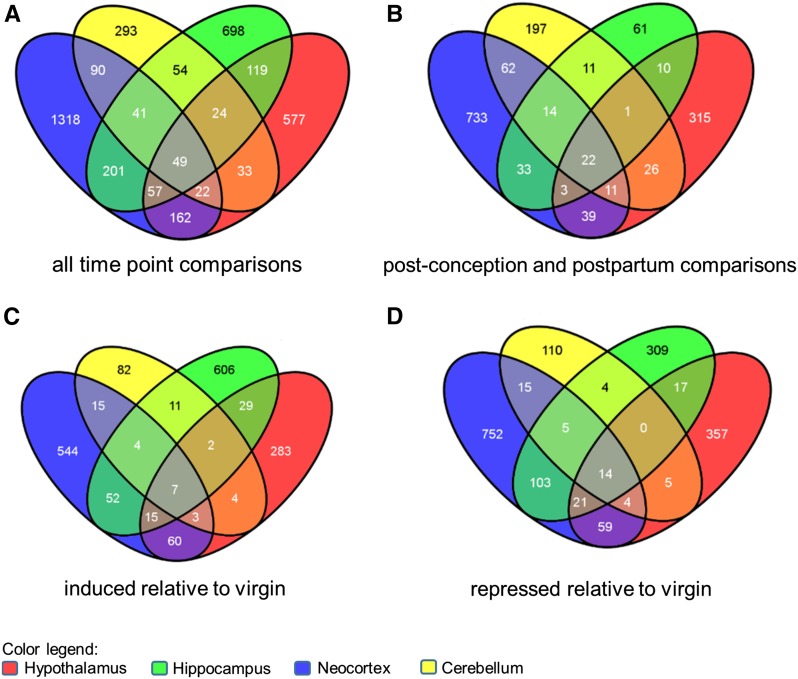
Brain regions have distinct and overlapping sets of differentially expressed genes. Venn diagrams illustrating the overlap of differentially expressed genes across the cerebellum (yellow), hippocampus (green), hypothalamus (red), and neocortex (blue) data sets. The diagrams were made using the online tool Venny (http://bioinfogp.cnb.csic.es/tools/venny/index.html). (A) A gene is included in this analysis if it was differentially expressed in any pairwise comparison. (B) A gene is included in this analysis if it was differentially expressed between or within any PC and PP time points. (C) A gene is included in this analysis if it was induced relative to virgin gene expression in a PC or PP time point. (D) A gene is included in this analysis if it was repressed relative to virgin gene expression in a PC or PP time point.